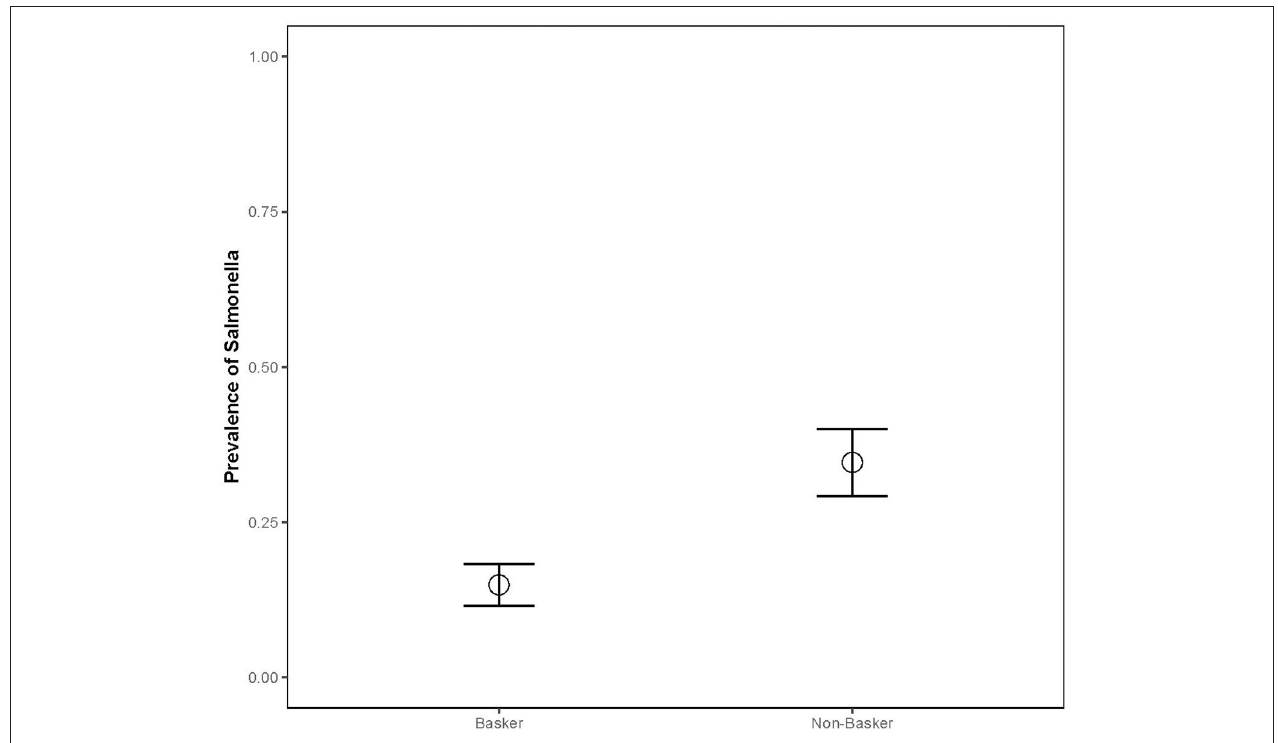
FIGURE 3 | Salmonella prevalence of aquatic turtle species varied based on their basking behavior (2012–2013). CHPIC and TRSCR were classified as baskers, while CHSER, STODO, and STMIN were classified as non-baskers. APSPI were not included in basking analysis due to sample size and inconsistent basking